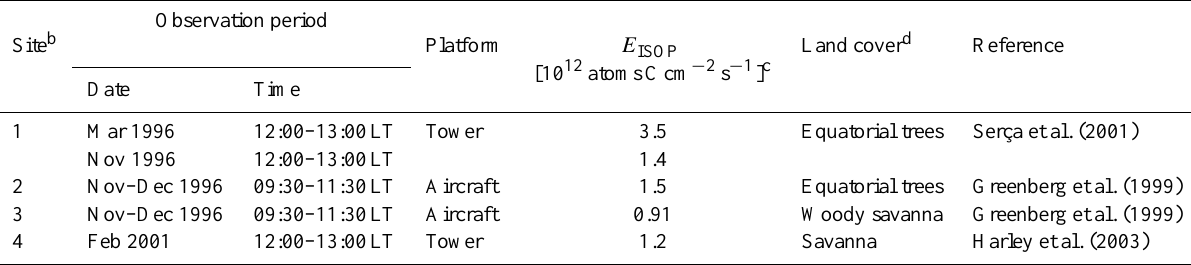
Table 1a. Relaxed-eddy accumulation (REA) isoprene flux measurements in Africa a .